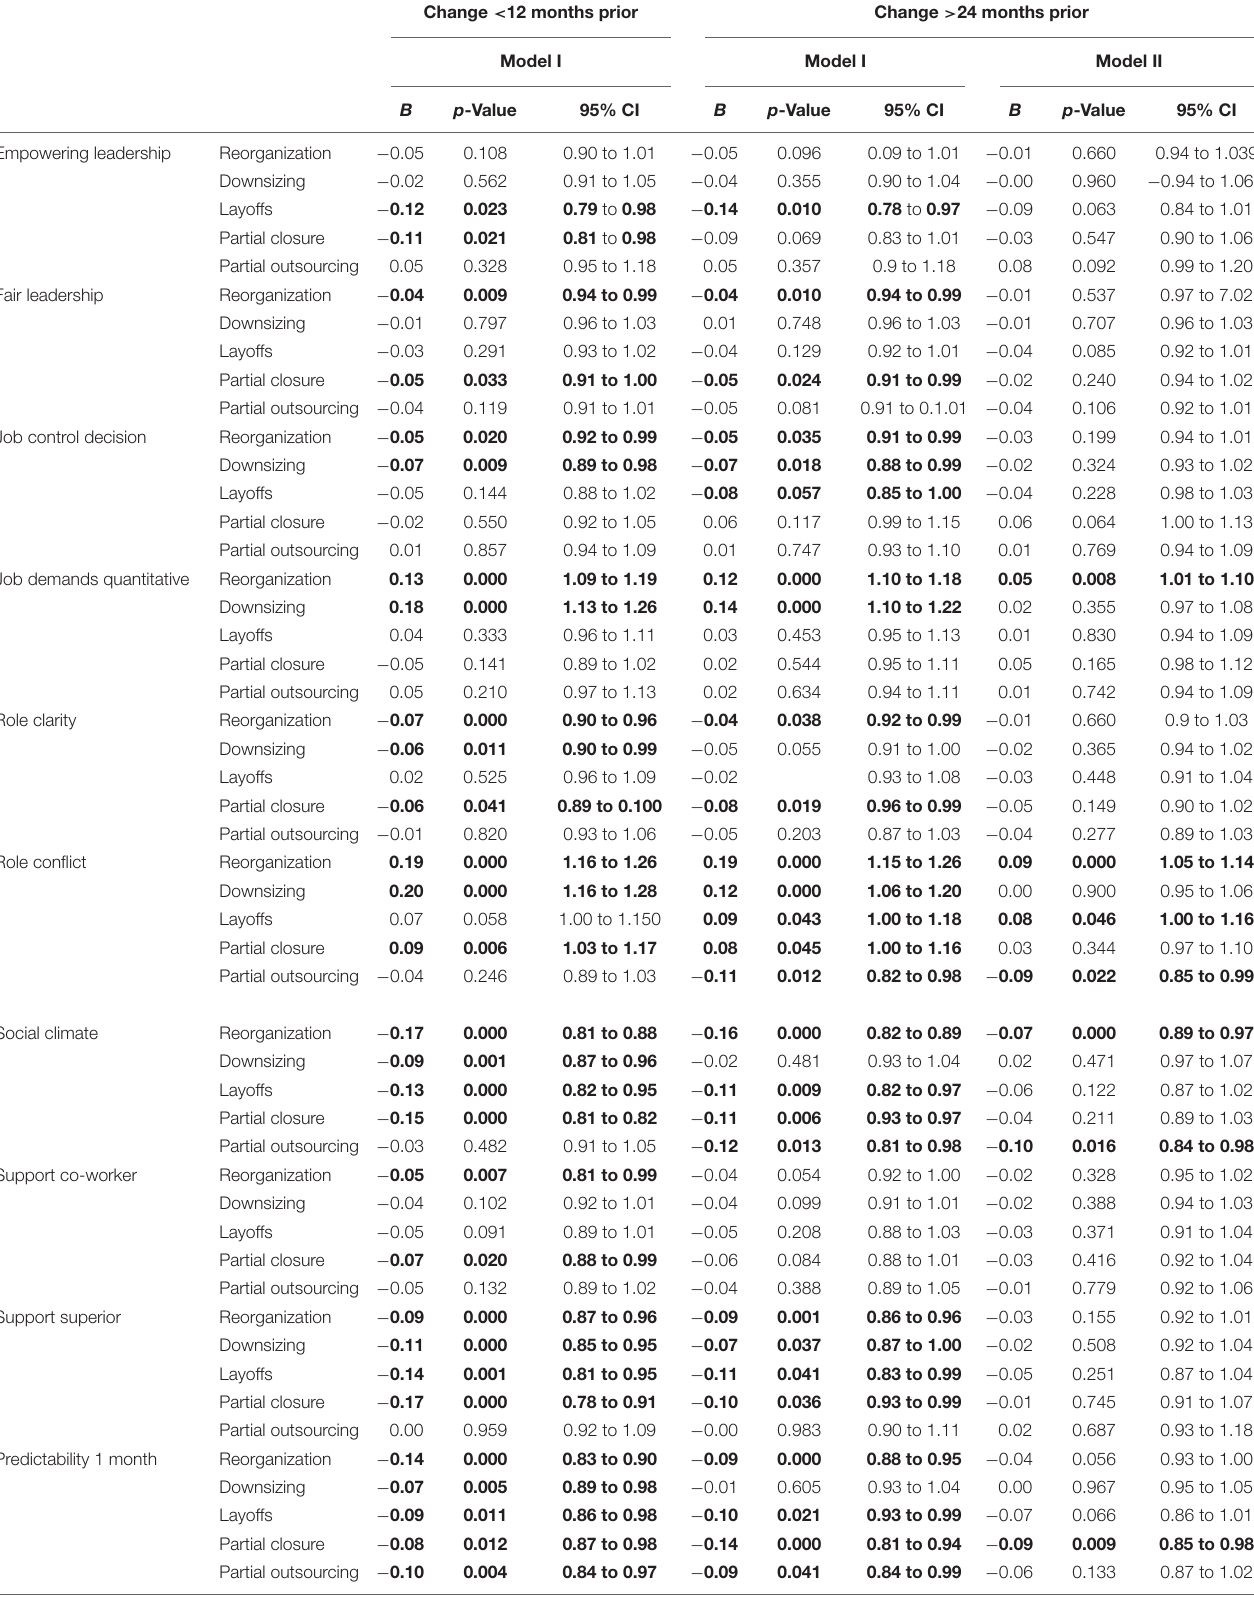
TABLE 5 | Separate organizational